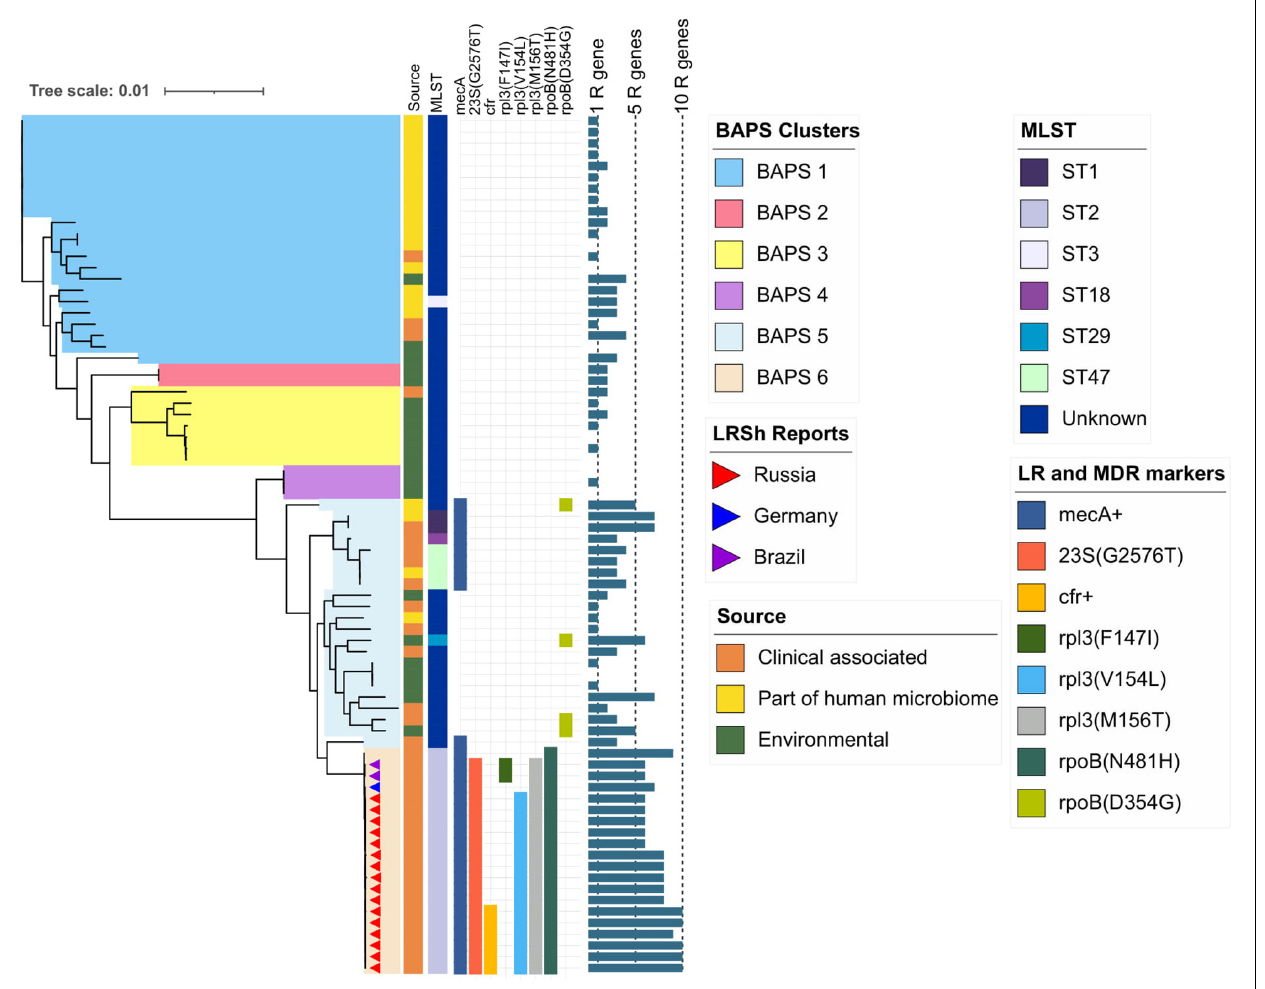
FIGURE 4 | Maximum-likelihood phylogeny of S. hominis population (76 genomes) based on core-SNP alignment. Background color fill is matched to BAPS clustering (BAPS 1 to BAPS 6). Linezolid-resistant S. hominis isolates (LRSh reports) marked as triangles on the tree. Annotation included source of genomes, MLST, linezolid resistance markers (LR): 23S rRNA mutation G2576T, rpl3 (Phe147Ile, Val154Leu, and Met156Thr), cfr ; and multidrug-resistance markers (MDR): mecA and mutations in rpoB (Asn481His, Asp354Gly); bar chart is matched to the number of acquired resistance genes from 0 to 10 genes per genome (1R gene to 10R genes). The following genes were screened (mutations were not included): aac(6 (cid:48) )-aph(2 (cid:48)(cid:48) ), aadD, ant(6)-Ia, ant(9)-Ia, aph(3 (cid:48) )-III, blaZ, cat, ermC, fexA, cfr, fosB, fosD, fusB, fusC, lnu(A), lsa(B), mecA, mph(C), msr(A), str, tetK, tetL, vgaA, and